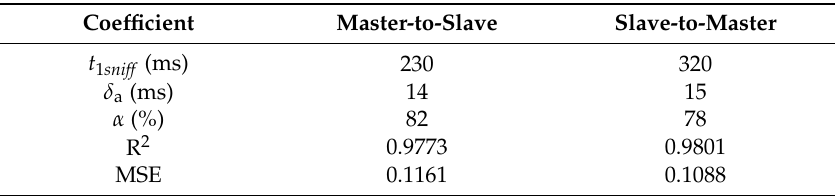
Table 2. Values of the coefficients in Equation (2) for master-to-slave and slave-to-master multi-hop communication with nodes in sniff